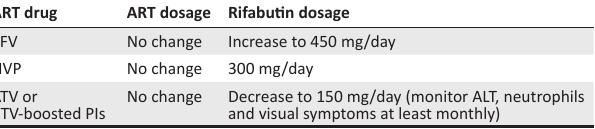
TABLE 9: Dosing of antiretroviral therapy drugs and rifabutin when prescribed concomitantly.